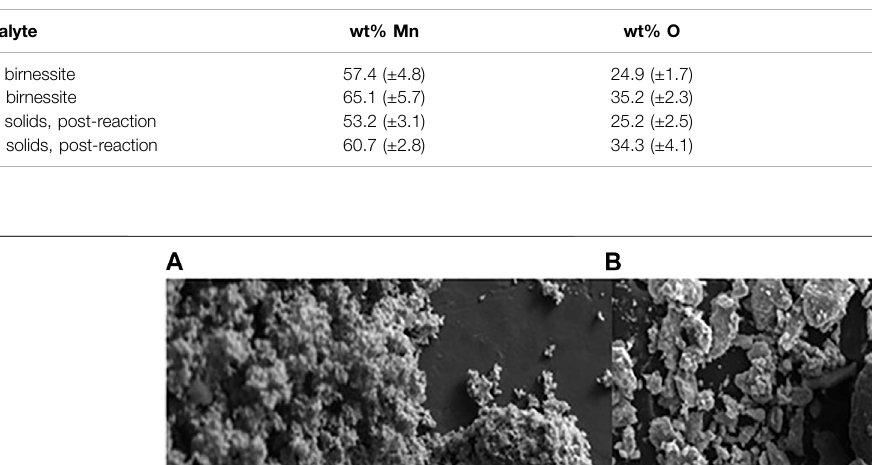
TABLE 4 | Elemental composition of the two birnessite types (AR= acid-reduction, SG= sol-gel) and the solid particles collected after the experiments have elapsed. 2